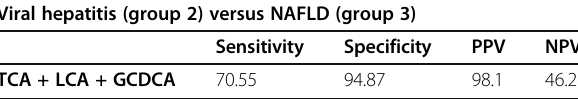
Table 4 Sensitivity, specificity, and diagnostic accuracy of combined TCA, LCA, and GCDCA to distinguish viral hepatitis group from NAFLD group